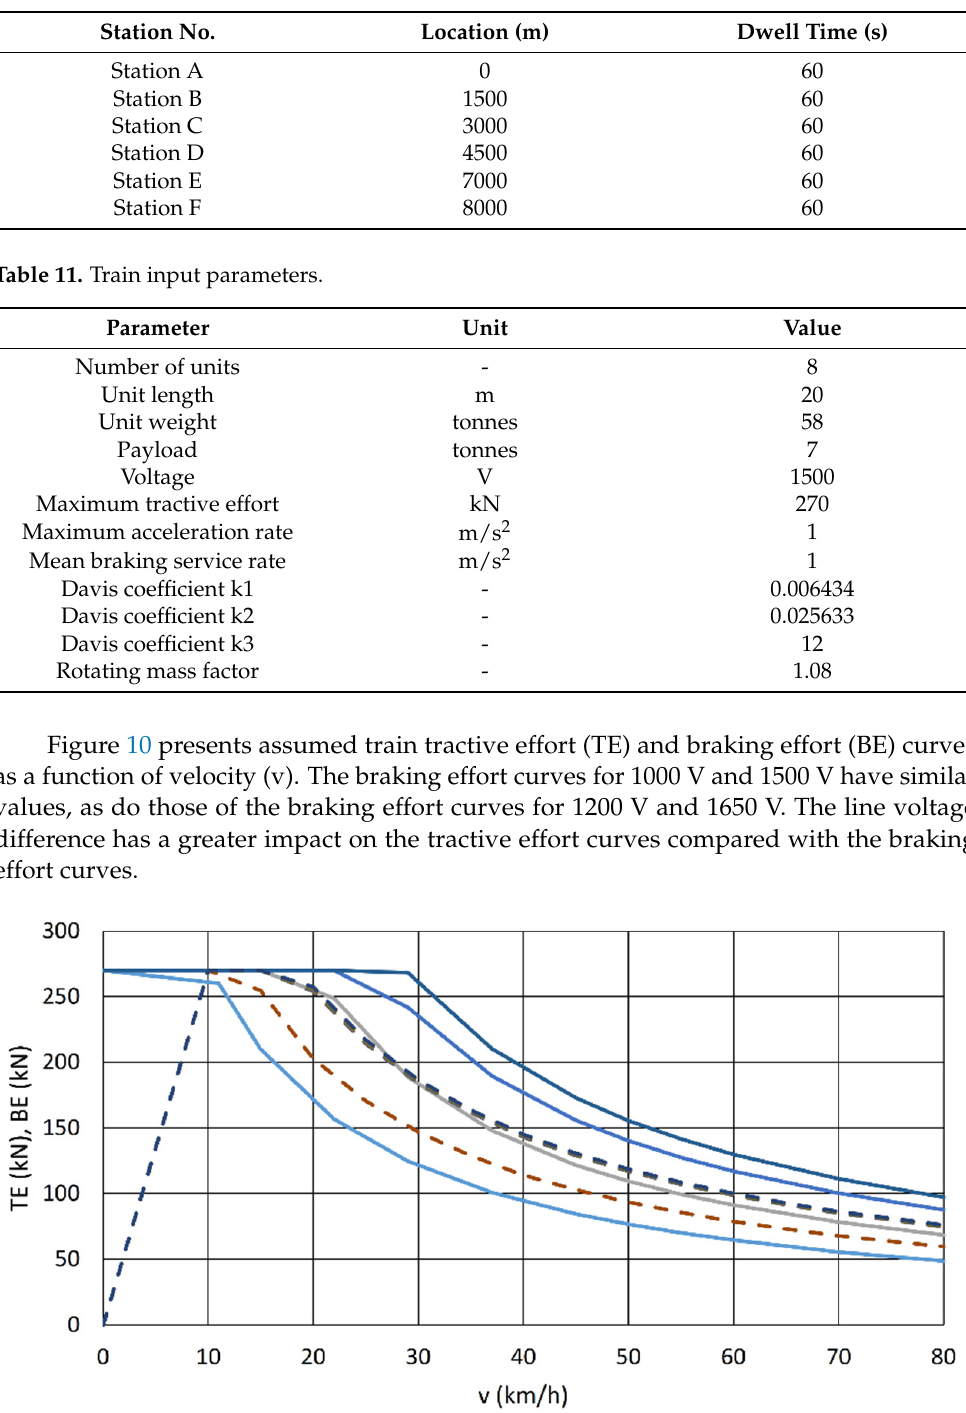
Table 10. Station input parameters.